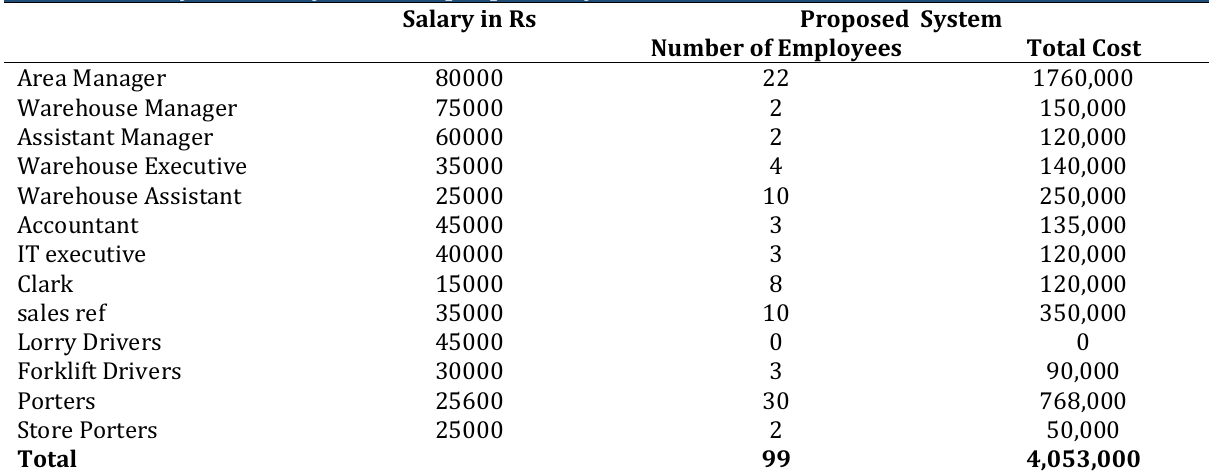
Table 9: Salary cost analysis of the proposed system